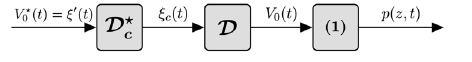
Figure 12. Block diagram of the corrector evaluation, with the target Eulerian fi eld as input V H pressure as output p ð z ; t Þ .